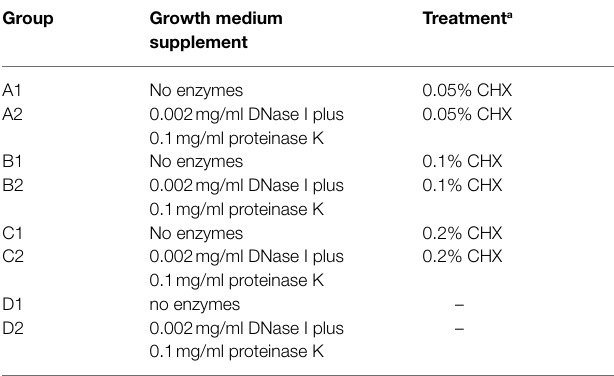
TABLE 1 | Arrangement of the biofilms into eight different treatment groups.